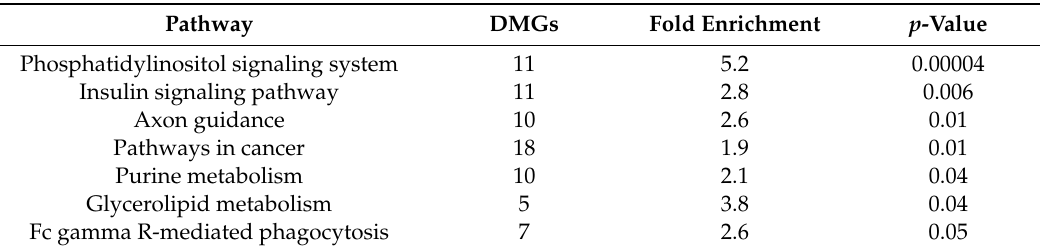
Table 2. Pathway